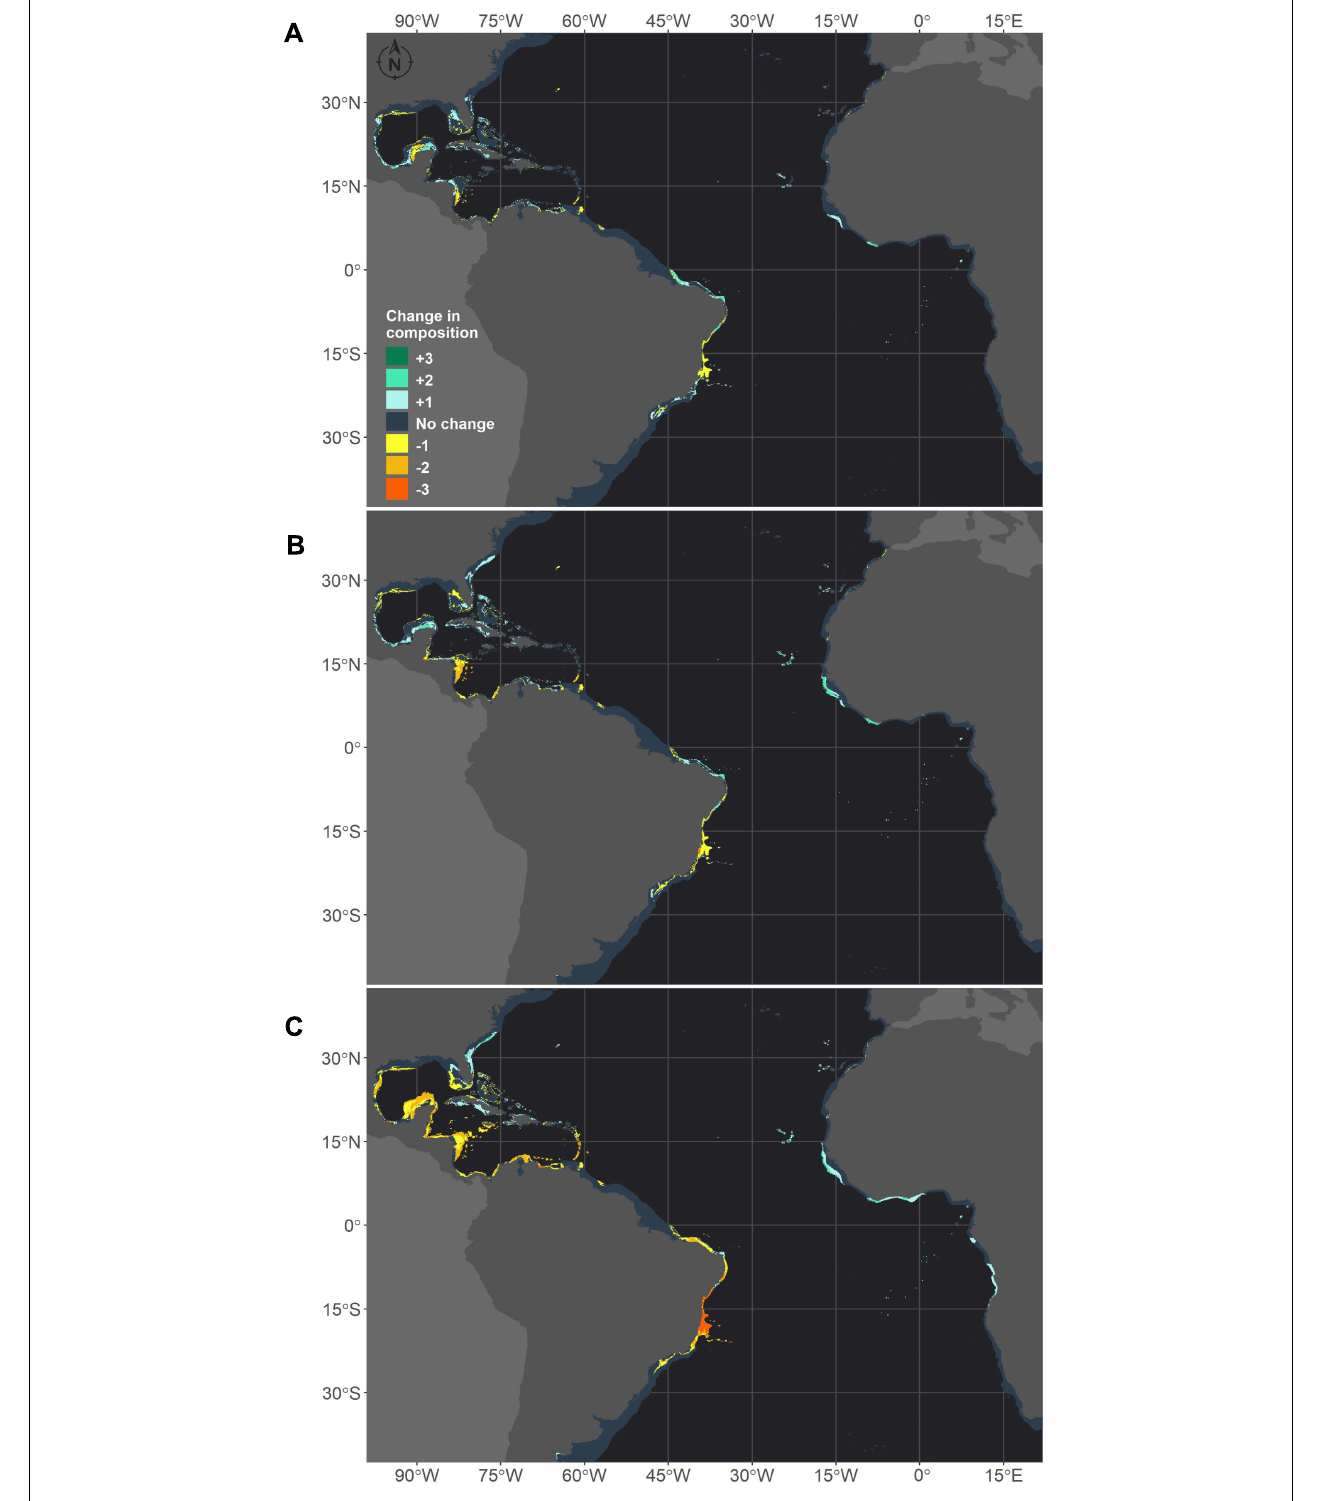
FIGURE 7 | Future composition of adequate habitats for reef builder species in the western Atlantic obtained through species distribution models generated for three species: M. hispida , M. cavernosa and Siderastrea sp. Map (A) shows the number of species gained (positive values – green scale) or lost (negative values – yellow scale) in the RCP2.6 scenario in comparison to the current climate. The same is shown for the RCP4.5 (B) and RCP8.5 (C) scenarios. The dark gray depicts no change in the number of species.